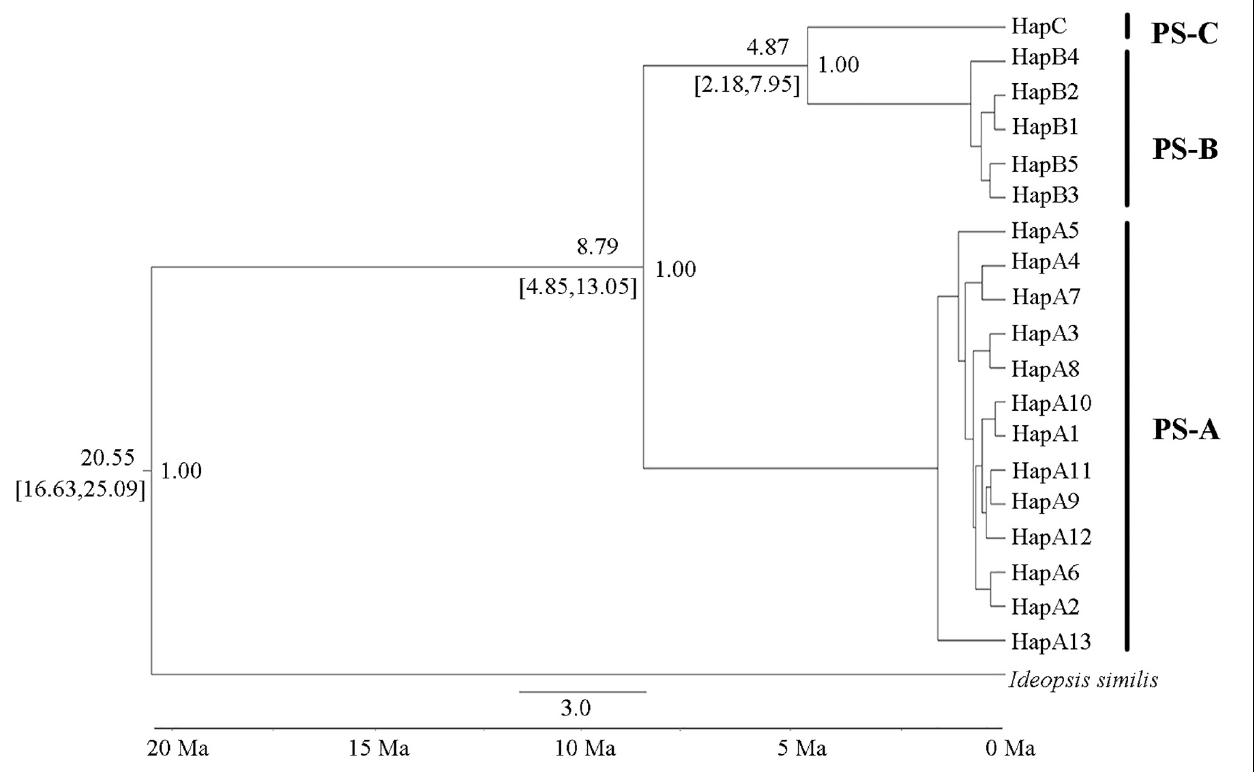
Fujioka, 1970, mainly distributed in Tibet and western